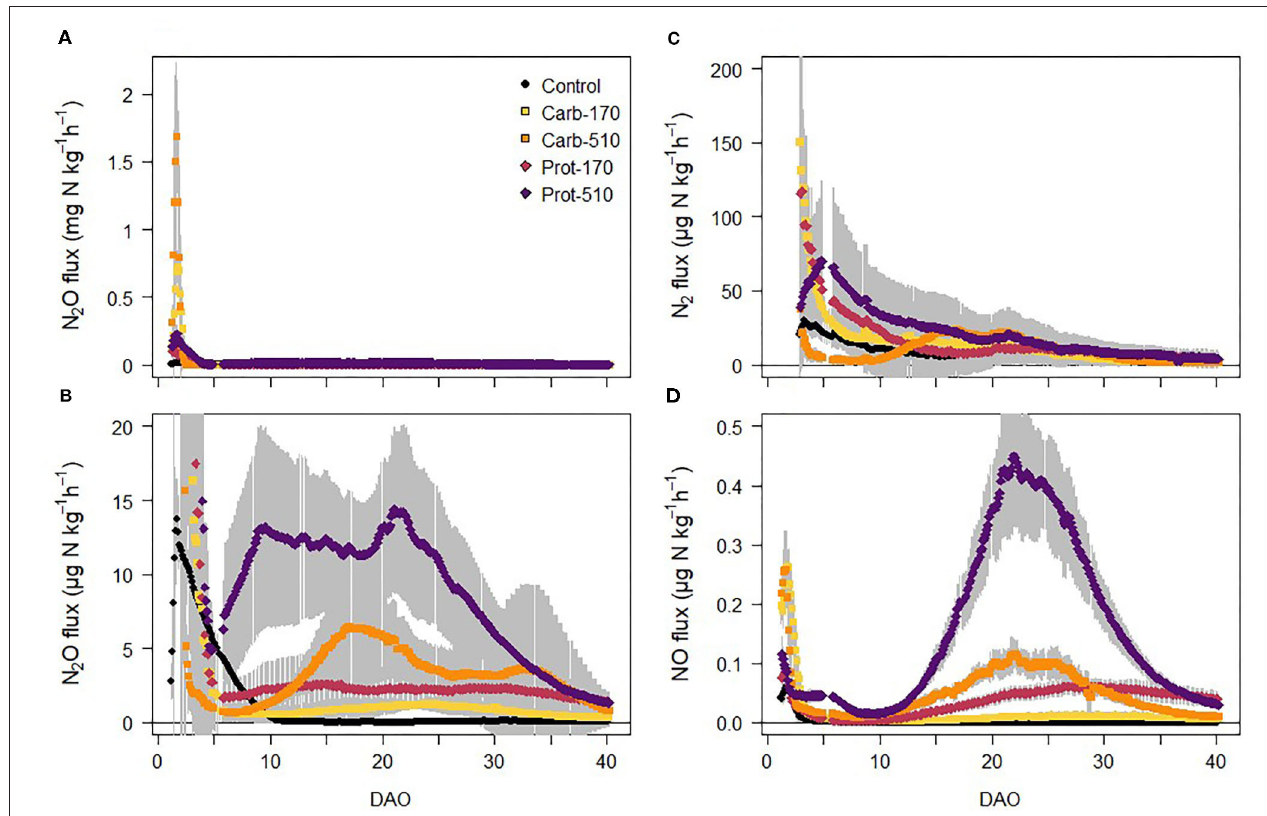
FIGURE 4 | (A,B) N 2 O fluxes, (C) N 2 fluxes, and (D) NO fluxes from soil during the incubation experiment (mean ± standard deviation for n = 4, for Prot-170 n = 3).